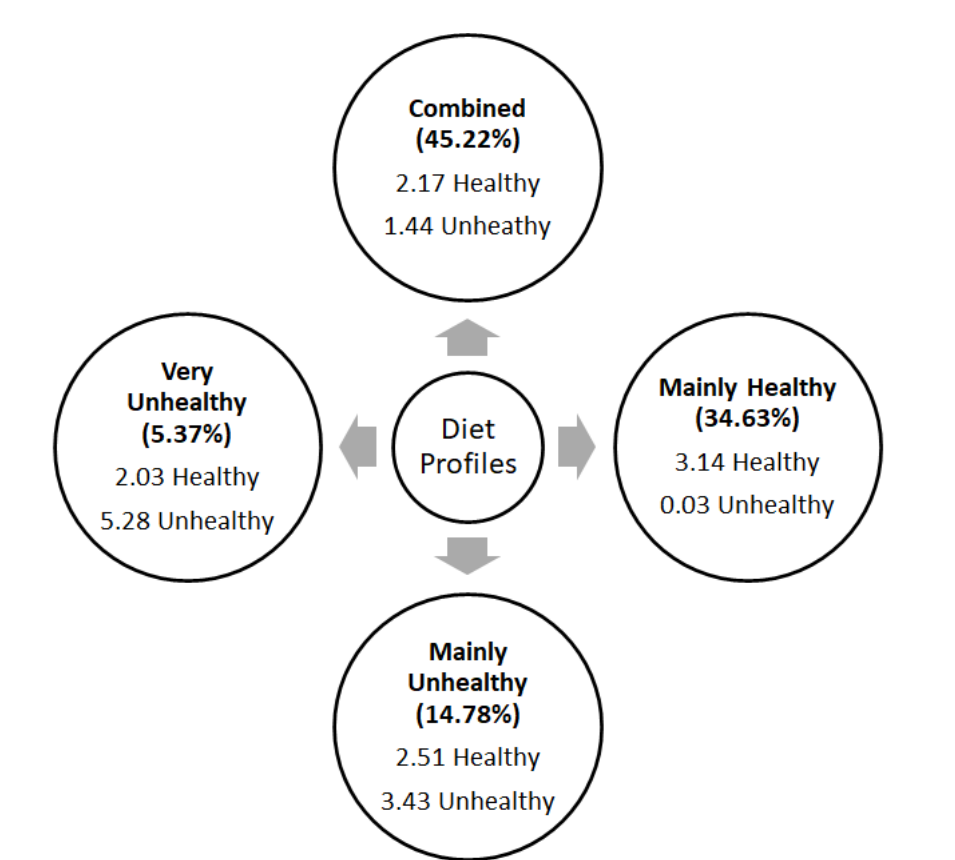
Figure 2. Graphical representation of the mean frequency of healthy and unhealthy daily food consumption in the distinct diet profiles.